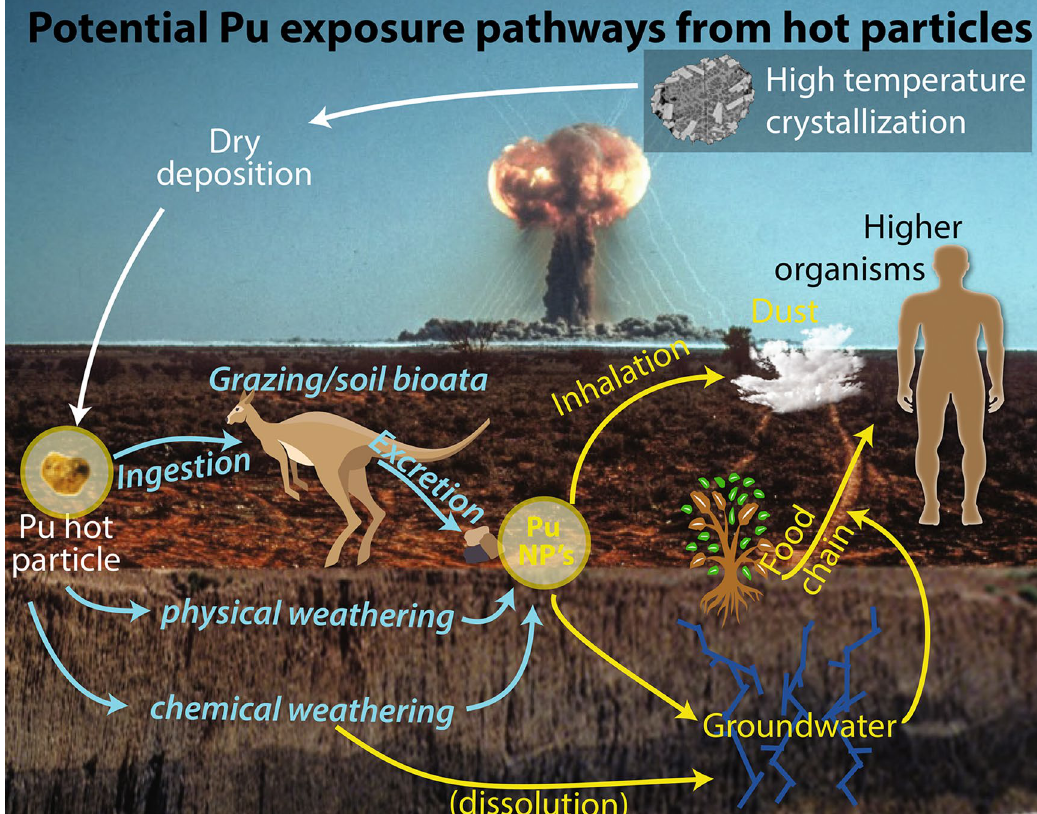
Figure 6. Inferred exposure pathways at Maralinga: the nature of hot particles influences Pu cycling in the environment. The colours in the figure reflect: processes in explosion cloud (white), breakdown processes of Pu particle (blue), exposure pathways via mobile phases (yellow). The background image is from the UK Atomic Energy Authority/Atomic Weapons Research Establishment, available under the Open Government License (http:// www. natio nalar chives. gov. uk/ doc/ open- gover nment- licen ce/ versi on/3/) and National Archives of Australia A6456,